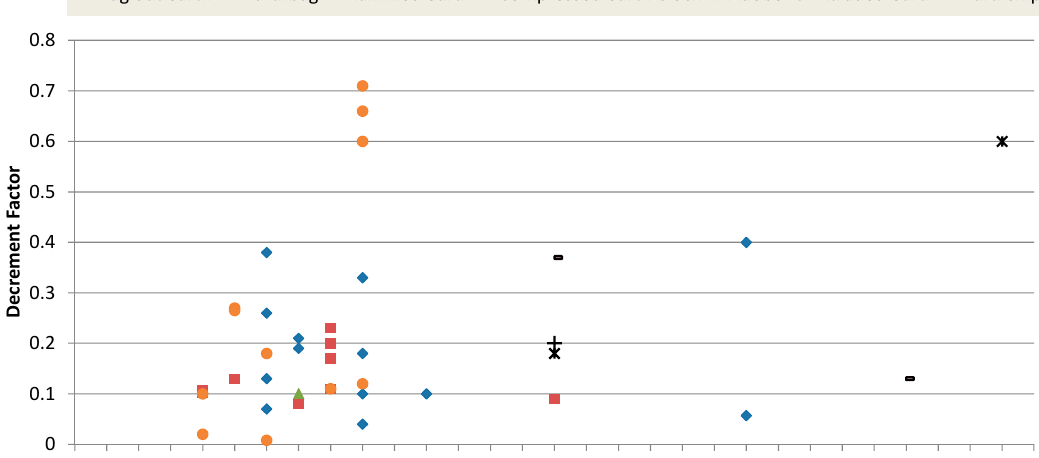
Figure 6. Decrement Factor according to the climate and the earth construction technique.